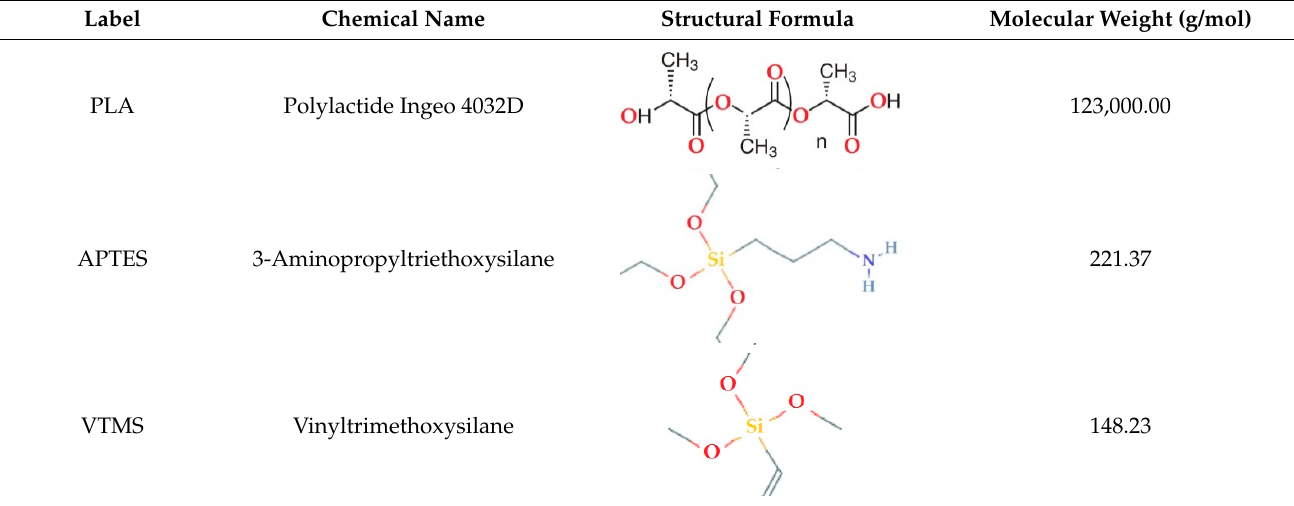
Table 1. Structure and chemical characteristics of poly(lactic acid) and silane molecules.